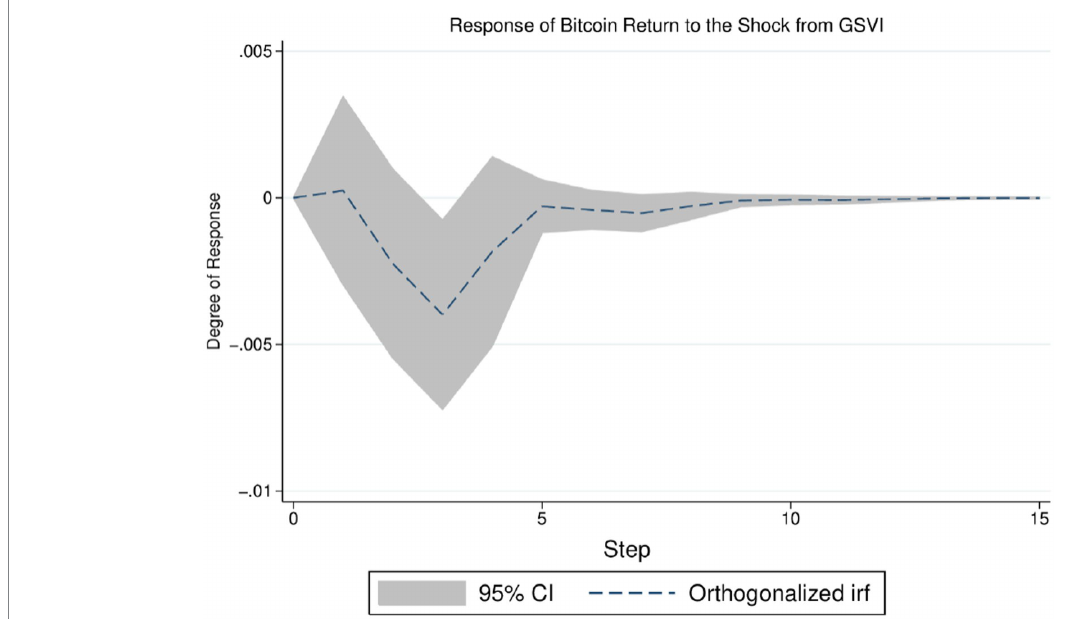
FIGURE 3 Response of Bitcoin returns to the shock from GSVI.